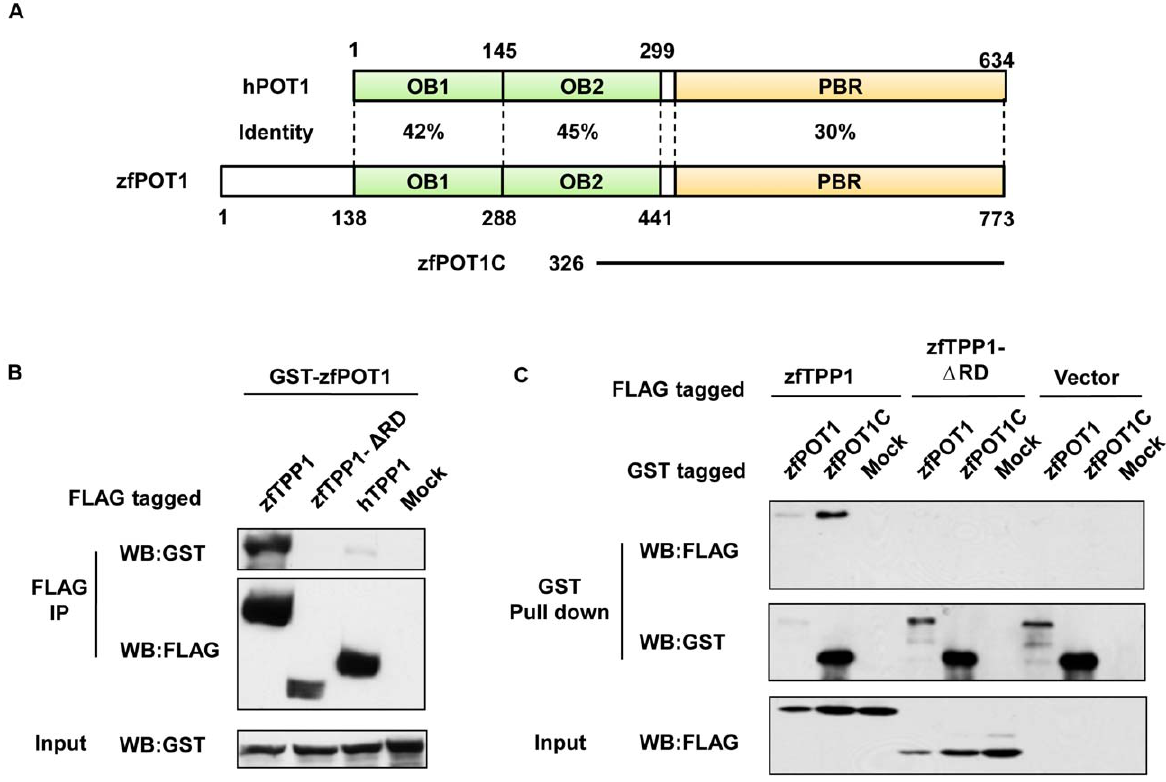
Figure 3. zfTPP1 interacts with zfPOT1. (A) Schematic representation of domain homology between human and zebrafish POT1. PBR, TPP1- binding region. (B) The RD domain is important for zfTPP1-zfPOT1 interaction. Extracts from 293T cells co-expressing GST-tagged zfPOT1 with FLAG- tagged full-length zfTPP1, zfTPP1- D RD (RD domain deletion mutant), or hTPP1 were immunoprecipitated with anti-FLAG antibodies, and analyzed by western blotting with the indicated antibodies. (C) The C-terminal region of POT1is important for its interaction with zfTPP1. Extracts from 293T cells co-expressing FLAG-tagged zfTPP1 or zfTPP1- D RD with GST-tagged full-length zfPOT1 or zfPOT1 C terminal domain (zfPOT1C) were immunoprecipitated with anti-GST antibodies and analyzed by western blotting with the indicated antibodies.